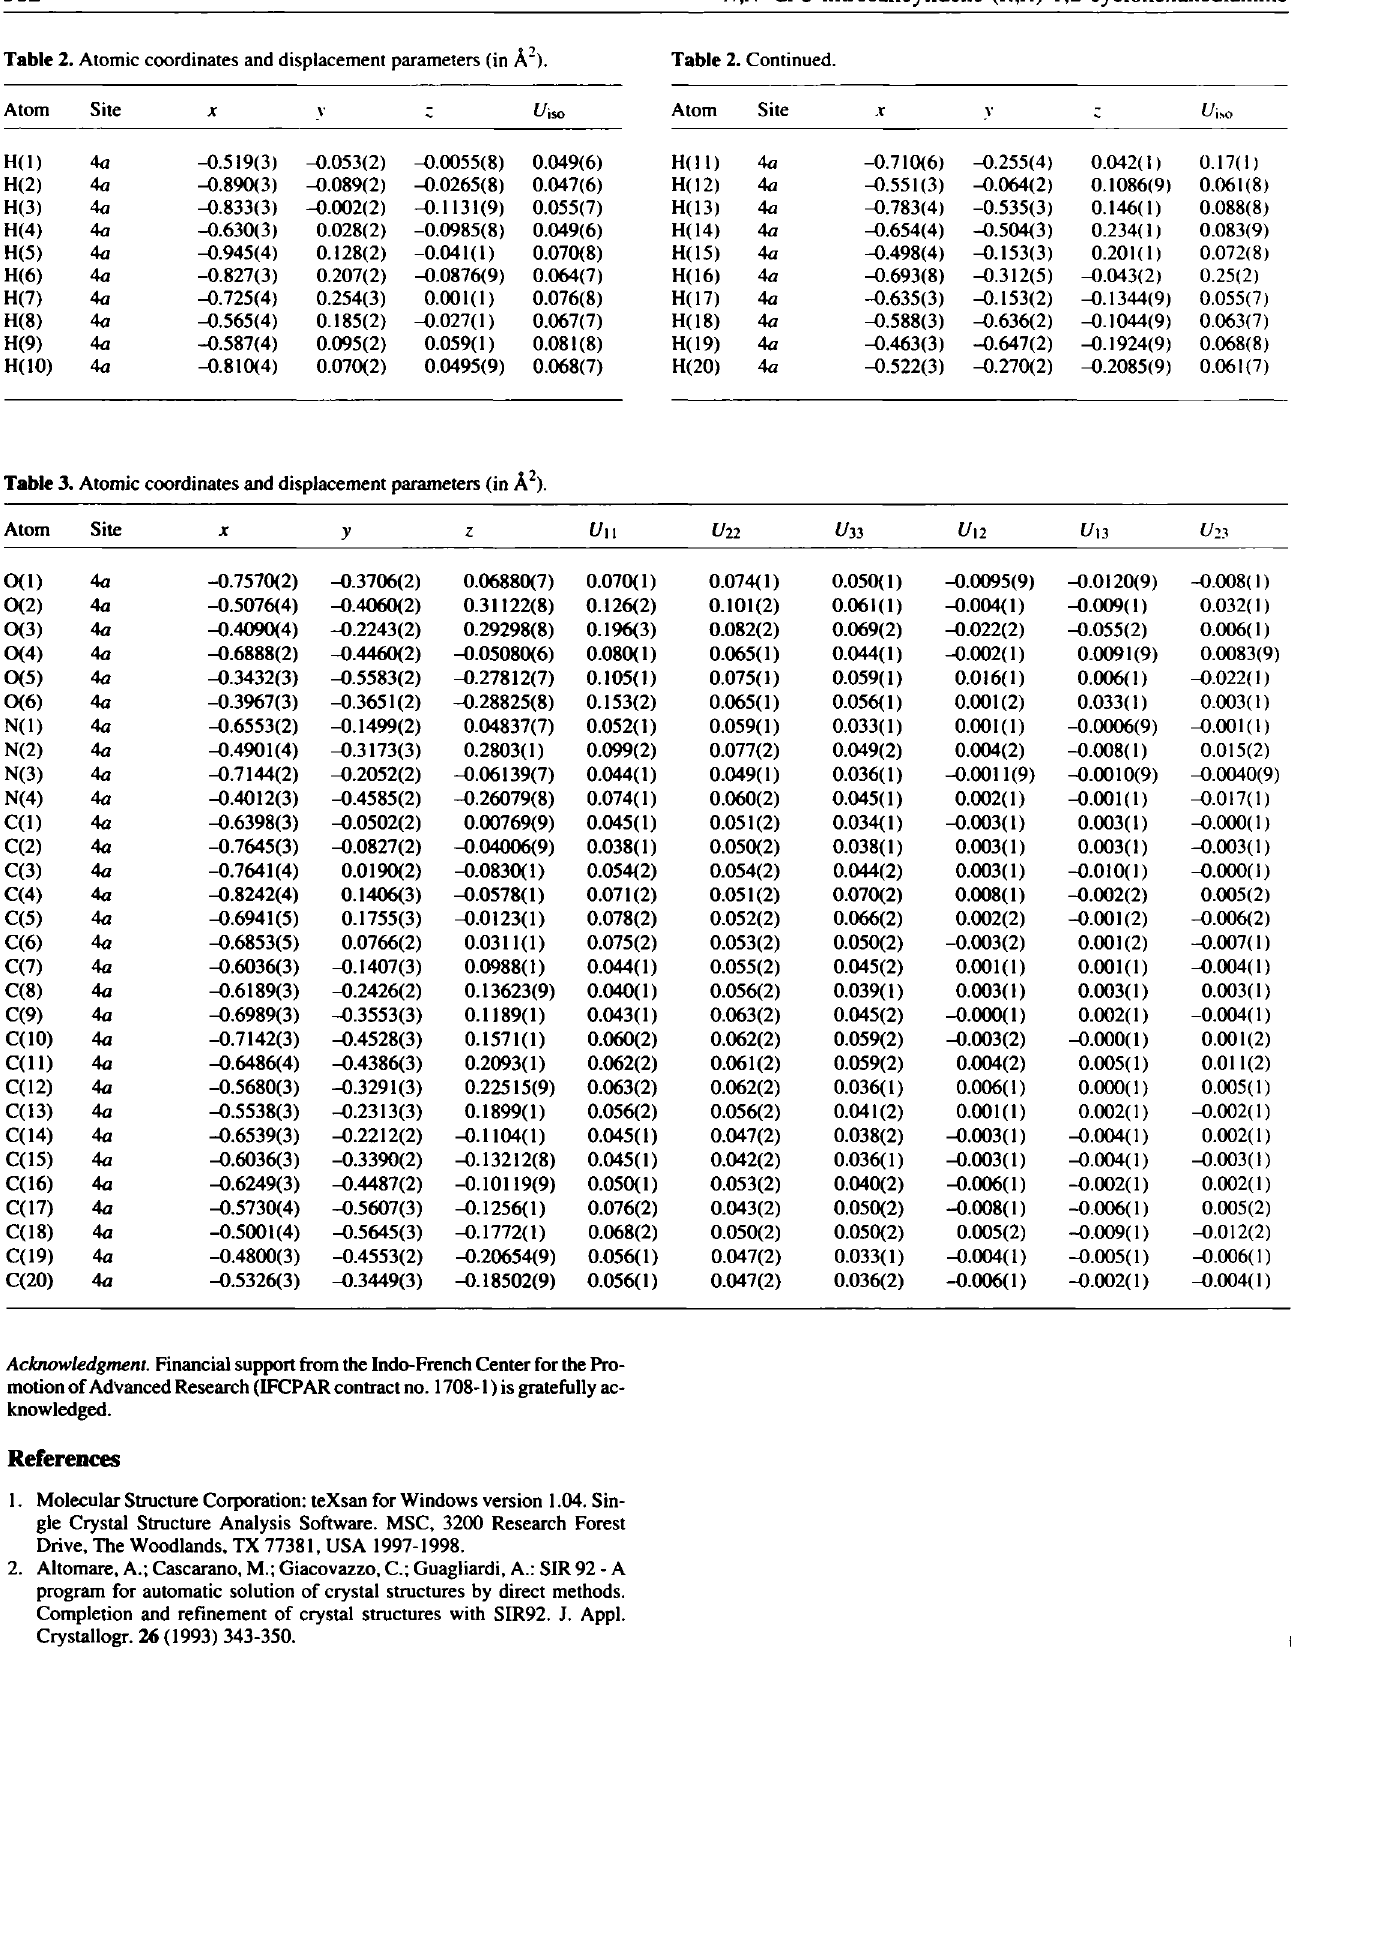
Table 2. Atomic coordinates and displacement parameters (in A~).